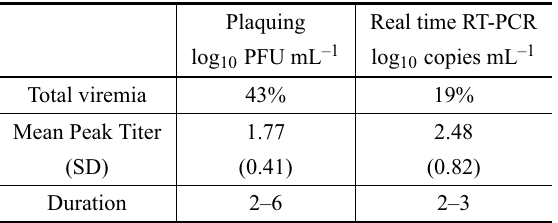
Viremia of 17D-DENV-4 recombinant